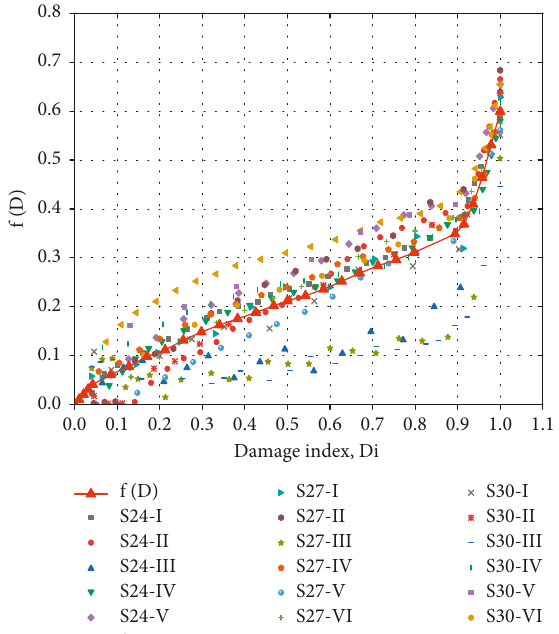
Figure 19: Relationship curve between bearing-capacity degra- dation function and damage